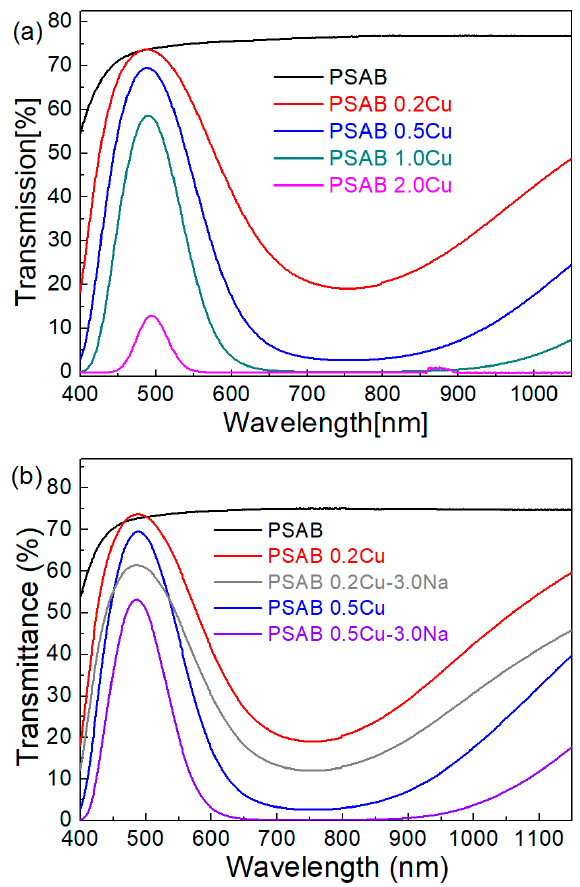
Figure 5. ( a ) Transmission spectra of PSAB system doped with various CuO concentrations; and ( b ) transmission spectra of PSAB system codoped with various CuO and Na 2 CO 3 concentrations.